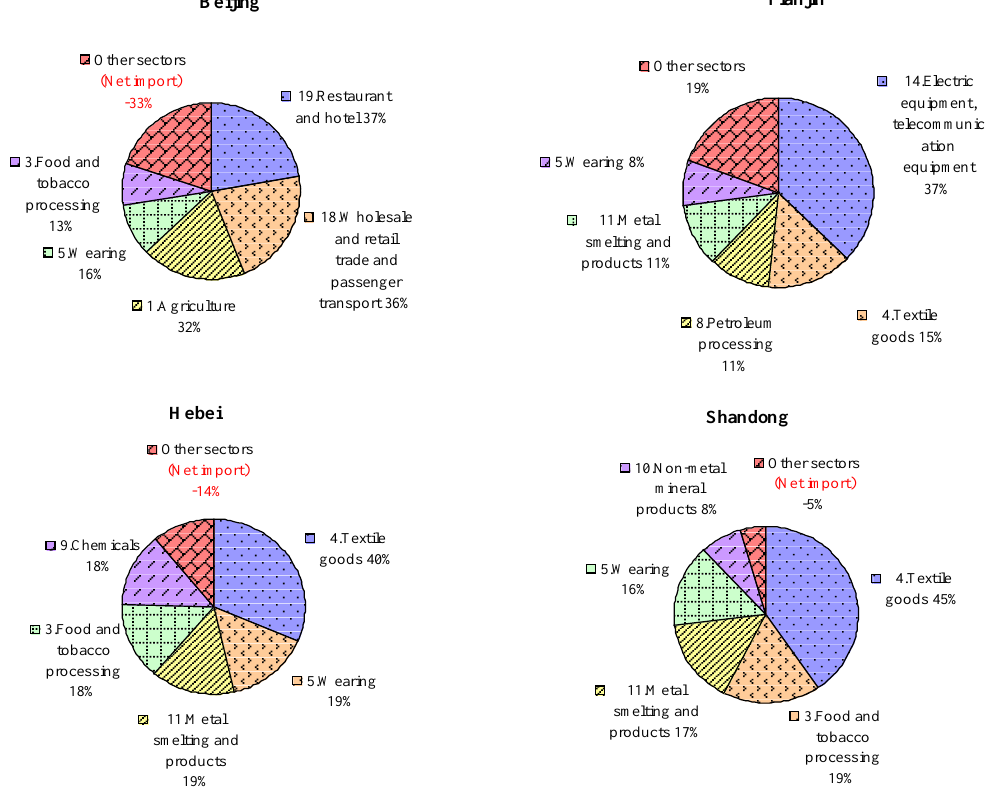
Fig. 4. The major net virtual water exporting sectors in the selected water scarce provinces (2002). Figure 4. The major net virtual water exporting sectors in the selected water scarce selected provinces. Apart from Sector 4 and Sector 5 provinces (2002) (The red slice in the pie chart is the sum of the net virtual water trade in the remaining sectors. The negative value indicates net import. The sum of the shares in each pie is 100%. The sum of the 5 major net virtual water exporting sectors can exceed 100% when the sign of the category ‘other sectors’ is negative.)